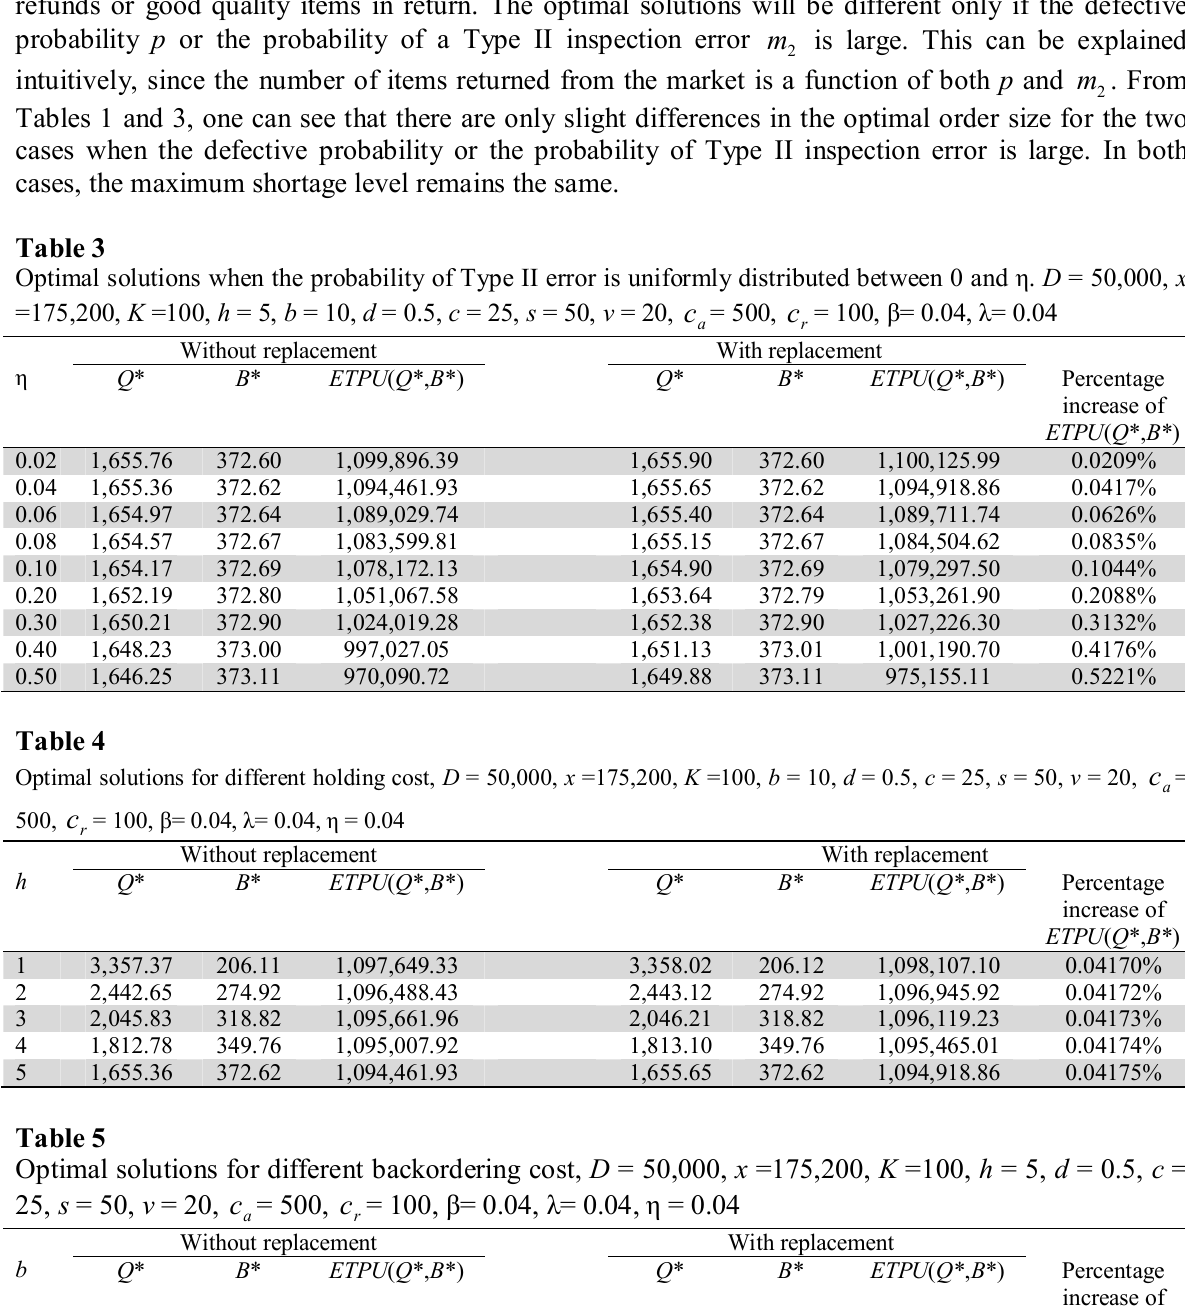
Optimal solutions when the probability of Type II error is uniformly distributed between 0 and η. D = 50,000, x =175,200, K =100, h = 5, b = 10, d = 0.5, c = 25, s = 50, v = 20,